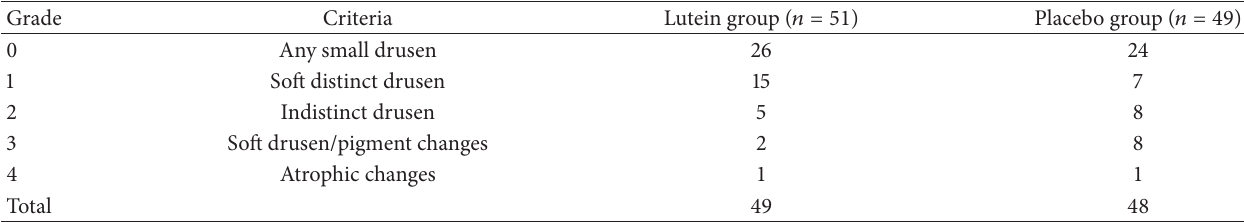
Table 1: Distribution of AMD at baseline in the present